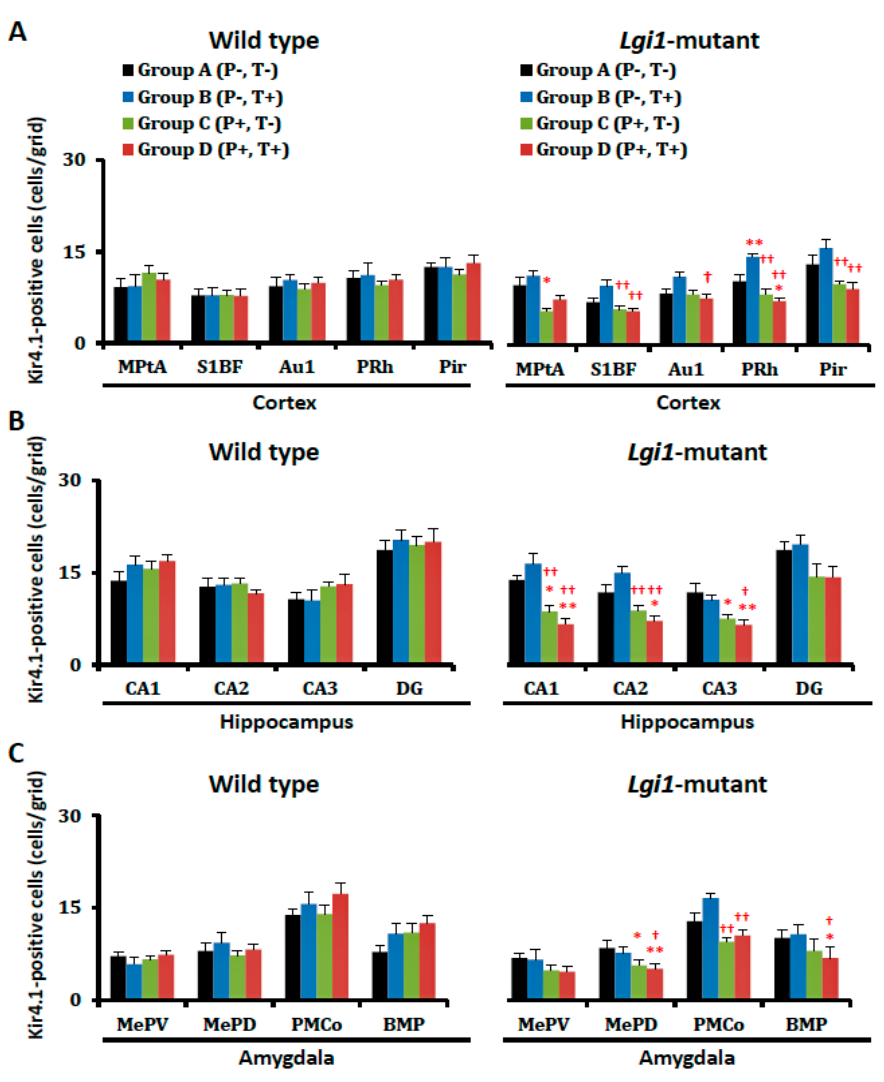
Figure 4. Changes in the number of Kir4.1-immunoreactivity (IR)-positive cells after development of audiogenic epilepsy. Kir4.1-IR-positive cells in each group of wild-type rats ( A – D ) and Lgi1 mutant rats are shown in each region of the cortex ( A ), hippocampus ( B ), and amygdala ( C ). Each point represents the mean ± S.E.M. of six to eight animals. * p < 0.05, ** p < 0.01, significantly different from Group A of wild-type rats and Lgi1 mutant rats. † p < 0.05, †† p < 0.01, significantly different from Group B of wild-type rats and Lgi1 mutant rats.